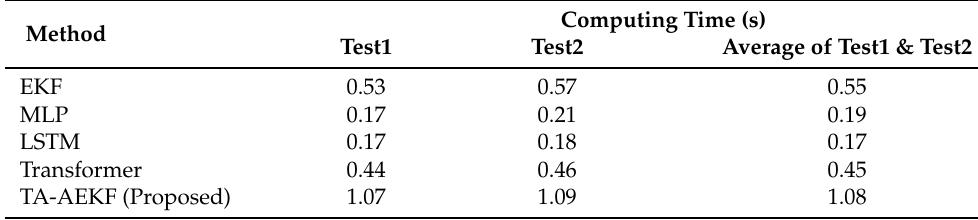
Table 7. Evaluation computing time of simulation